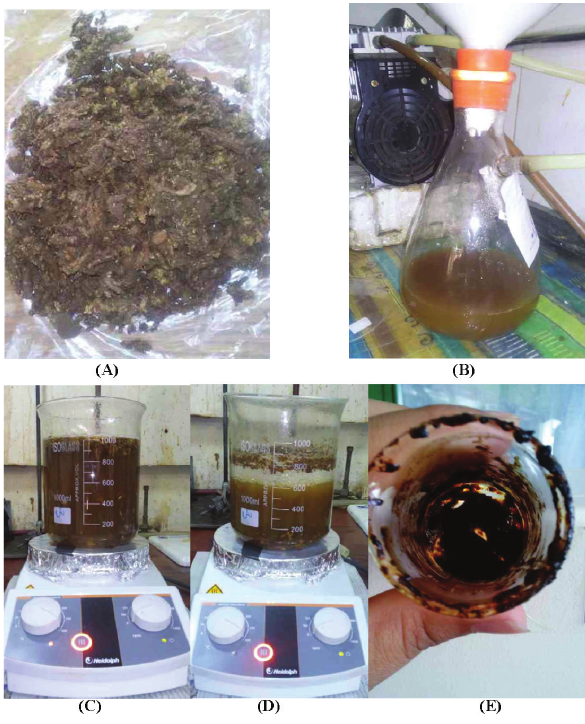
Figure 3: An illustration for different stages of Gypsophila aretioides extraction (a) grated roots, (b) aqueous extract, (c) clarified extract, (d) boiling extract and (e) dried extract.